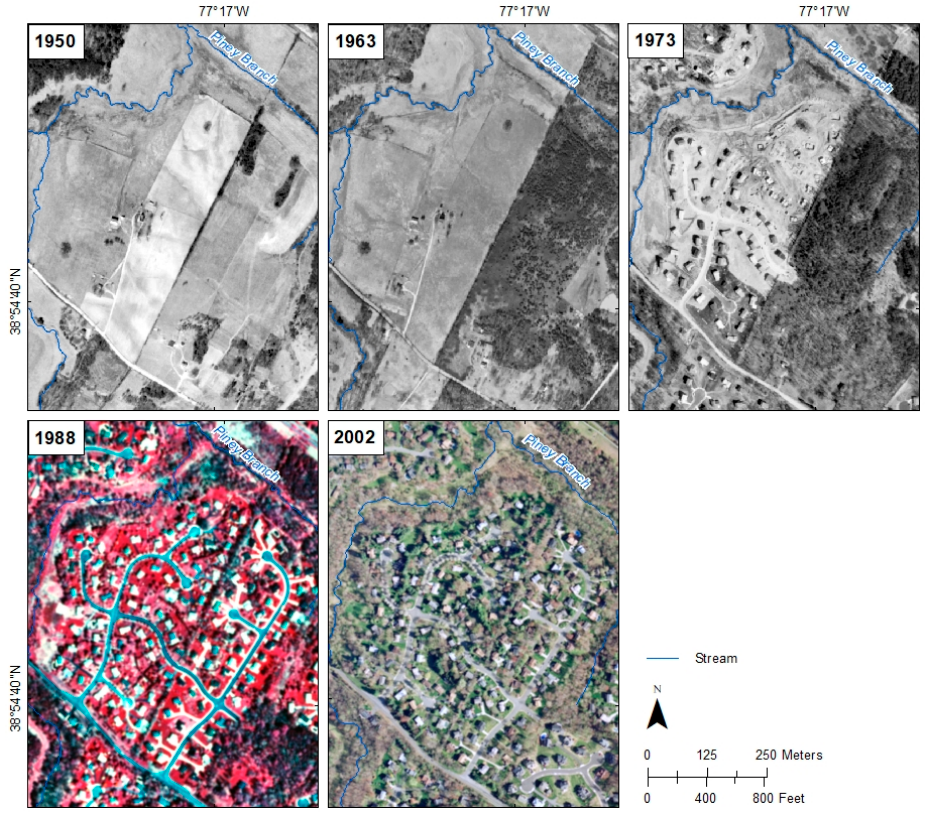
Figure 5. Orthoimages produced by SfM analysis. Table 4. Summary of SfM results for each set of historical aerial imagery.